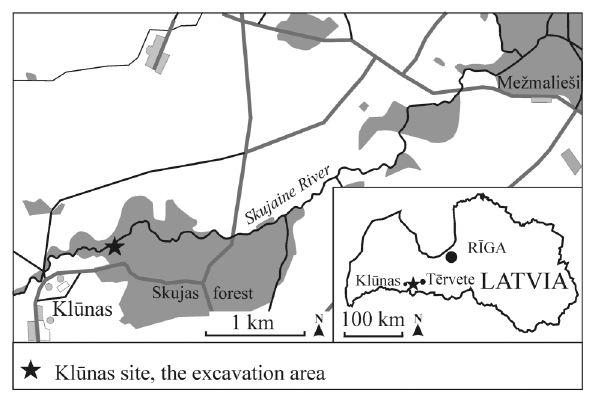
Fig. 1. Map of the vicinity of T ē rvete showing the location of the Kl ū nas fossil